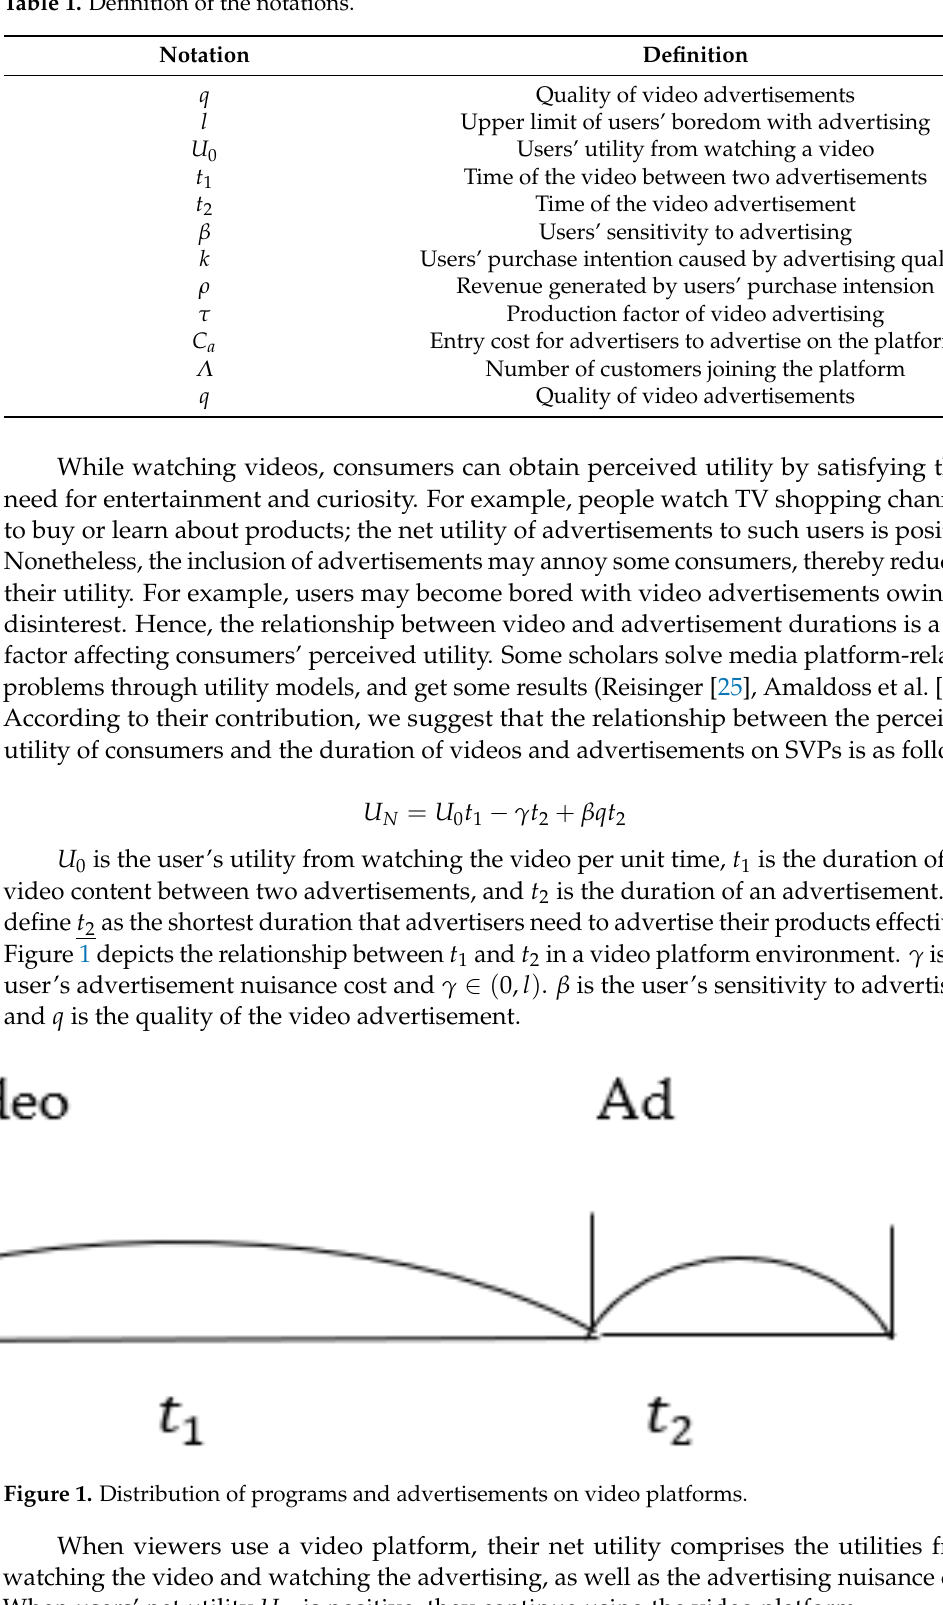
Table 1. Definition of the notations.